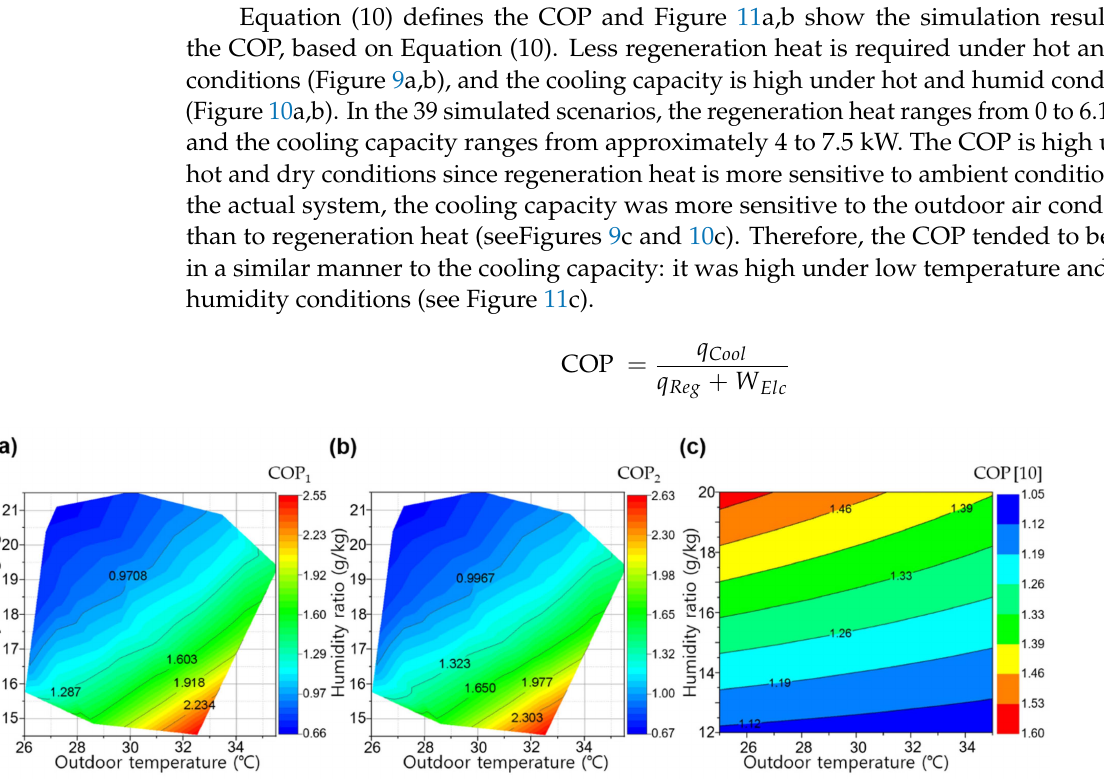
Figure 11. Coefficient of performance (COP) for ( a ) Unit 1 and ( b ) Unit 2. ( c ) Field test data [10] of the COP of the existing